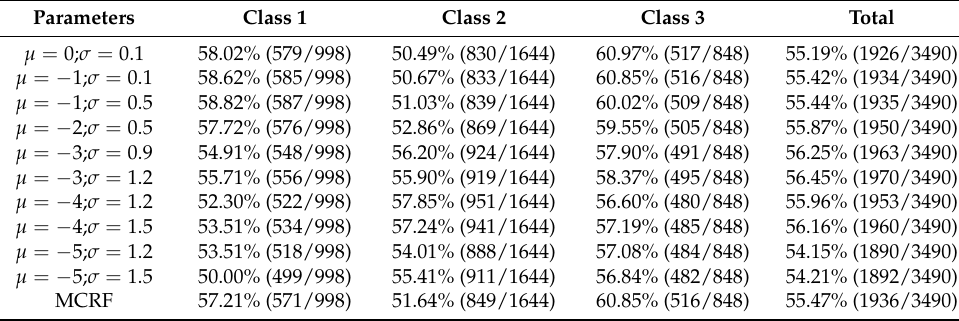
Table 1. Prediction accuracy comparison of the raster data set. μ and σ denote the mean and standard deviation, respectively.